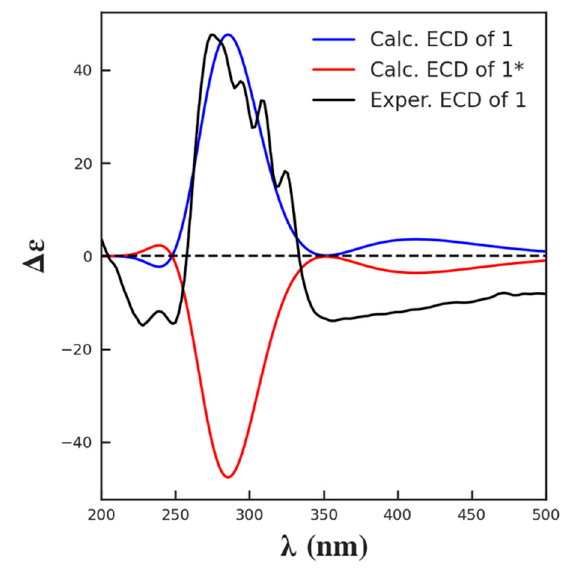
Figure 6. Experimental methanol ECD spectrum of 1 (black line) and theoretical ECD spectra of 1 (blue line) and its enantiomer 1* (red line).